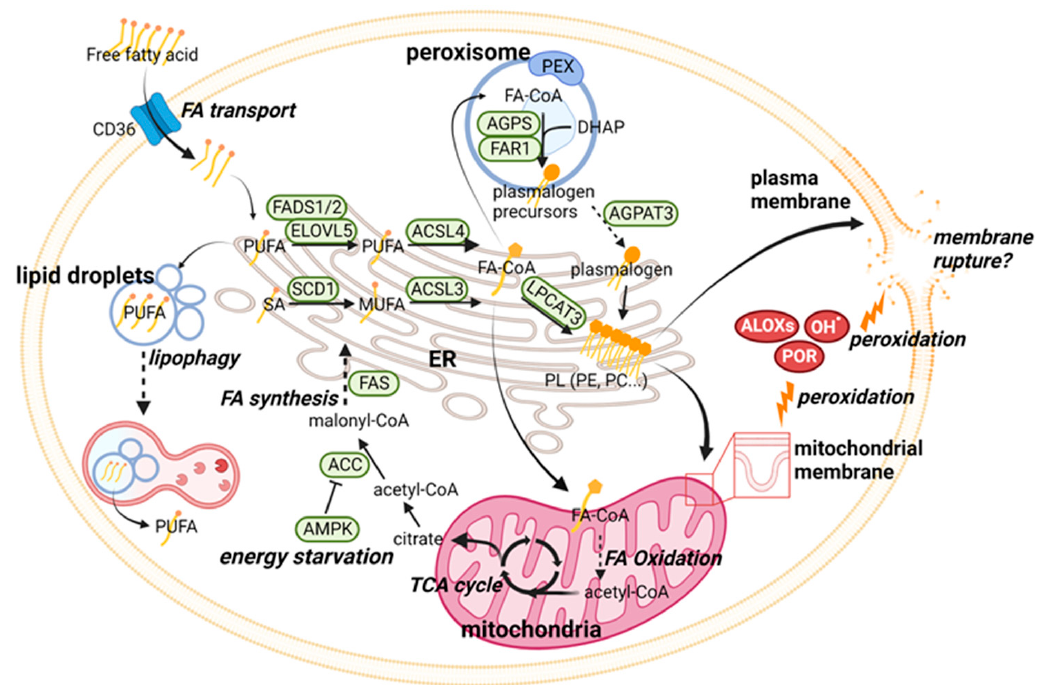
Figure 1. Phospholipid metabolism and its association with ferroptosis. Fatty acid biosynthesis as well as its degradation via fatty acid oxidation or lipophagy regulates ferroptosis through modulation of phospholipids. Membrane phospholipids containing polyunsaturated fatty acids are targeted by various oxidants for peroxidation leading to ferroptosis. Abbreviations—FA, fatty acid; SA, saturated fatty acid; MUFA, mono-unsaturated fatty acid; PUFA, polyunsaturated fatty acid; PL, phospholipid; ER; endoplasmic reticulum; FA-CoA, fatty acyl-CoA, DHAP, dihydroxyacetone phosphate. The image was created with BioRender (Toronto, ON, Canada) (BioRender.com).